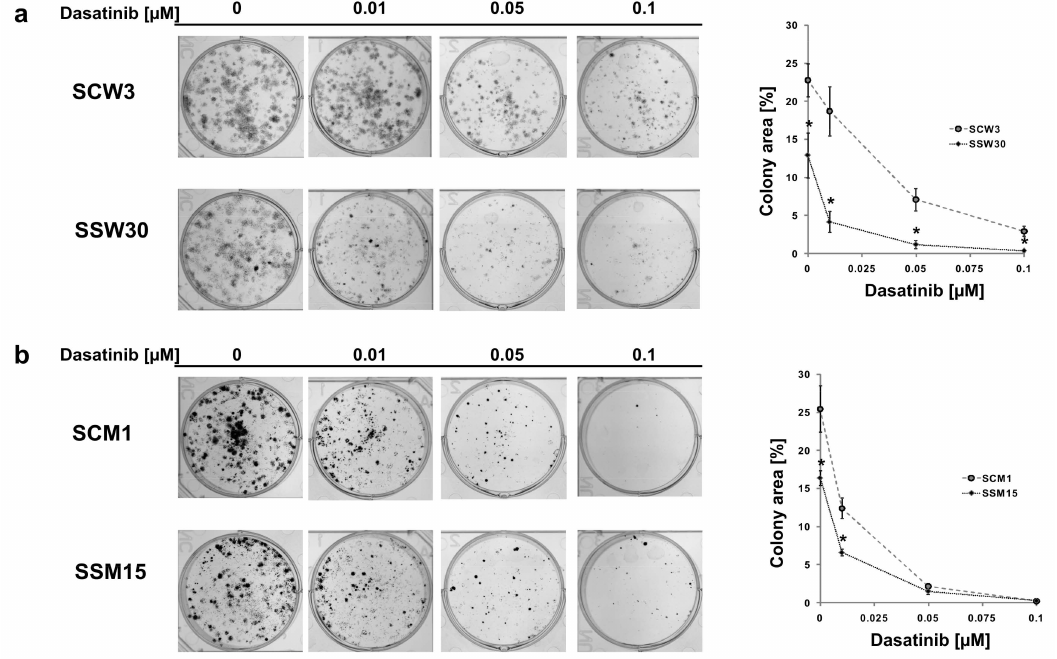
Figure 2. ( a ) E ff ect of dasatinib on the capacity of SCW3 and SSW30 cells to produce progeny as determined using the colony formation assay. Images from a single representative experiment (left panel) and a computer-generated area lacking values to illustrate the colony formation assay (right panel), mean ± SD, ( n = 4). * Indicates a statistically significant di ff erence at p < 0.05. ( b ) E ff ect of dasatinib on the capacity of SCM1 and SSM15 cells to produce progeny as determined using the colony formation assay. Image from a single representative experiment (left panel) and computer-generated area lacking values to illustrate the colony formation assay (right panel), mean ± SD, ( n = 4). * Indicates a statistically significant di ff erence at p <